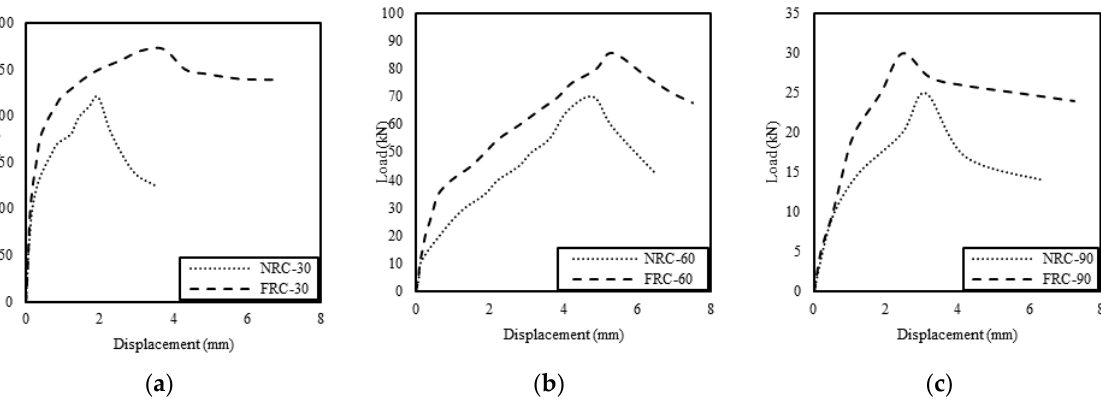
Figure 14. Load – relative displacement of V-shaped columns with ( a ) 30°, ( b ) 60°, and ( c ) 90° angles. The horizontal and relative displacement curves for the V-shaped columns are shown